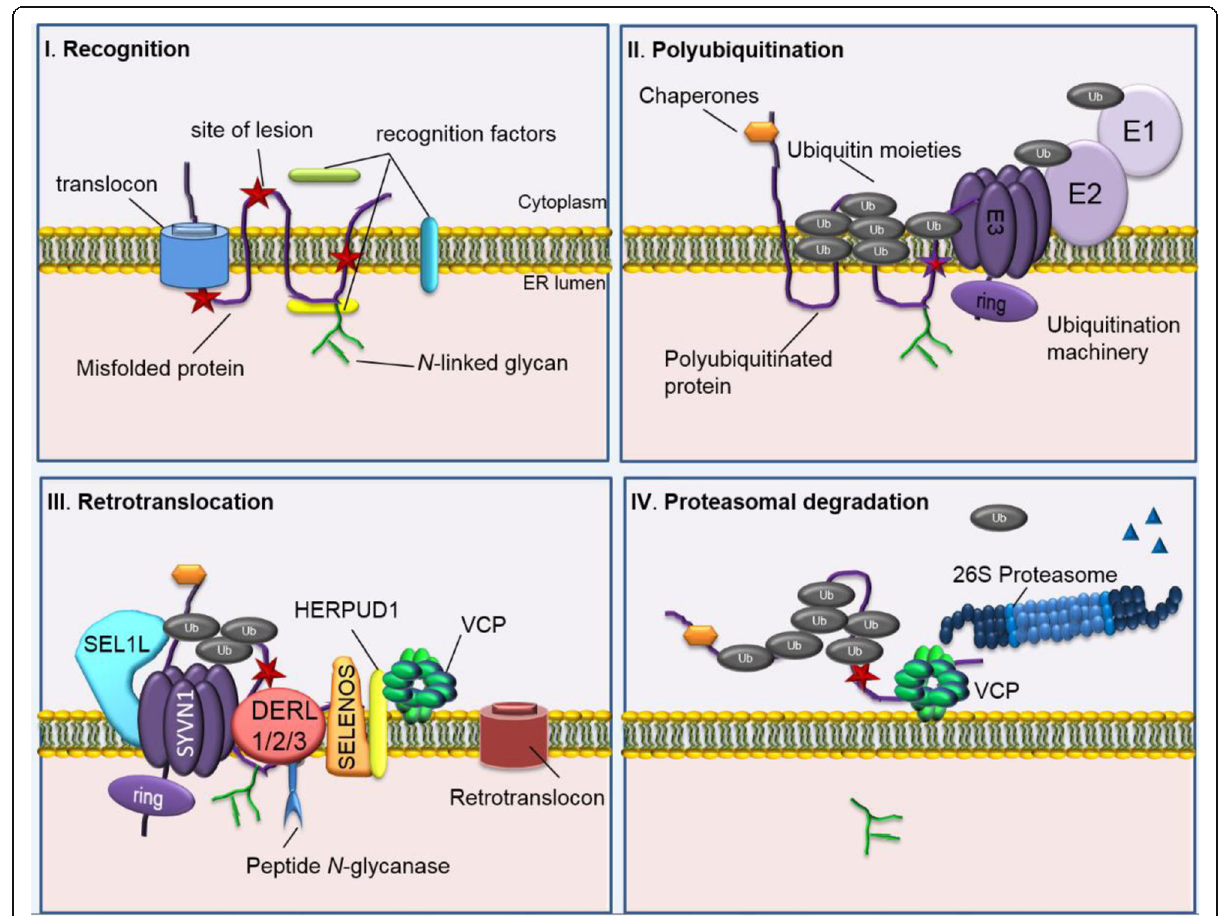
Fig. 3 The four main steps for ERAD. I . Recognition occurs during protein synthesis. Here a misfolded region (red stars) are recognized by either cytoplasmic, ER luminal and/or transmembrane recognition factors depending on the site of lesion. II. Polyubiquitination starts when chaperones and co-chaperones direct the misfolded substrate to ubiquitination machinery. An ubiquitin activating enzyme (E1) transfers ubiquitin (Ub) (grey circles) to cysteine residue in an active site of an ubiquitin conjugating enzyme (E2) using ATP as energy. Ubiquitin ligase then transfers Ub to a lysine residue on the substrate protein. The latter process occurs on either the ER or cytoplasmic side of the membrane. III . Retrotranslocation ensues when the substrate protein is escorted to the dislocation machinery made up of a protein scaffold such as SEL1L adaptor subunit of ERAD E3 ubiquitin ligase (SEL1L), synoviolin 1 (SYVN1), cytochrome c oxidase assembly factor 7 (COA7) (not shown), derlin 1,2,3 (DERL1,2,3), selenoprotein S (SELENOS), homocysteine inducible ER protein with ubiquitin like domain 1 (HERPUD1), and valosin-containing protein (VCP). The substrate protein is removed either by passing through a retrotranslocon or by complete elimination of the protein. This is mainly done by the cytoplasmic ATPases associated with diverse